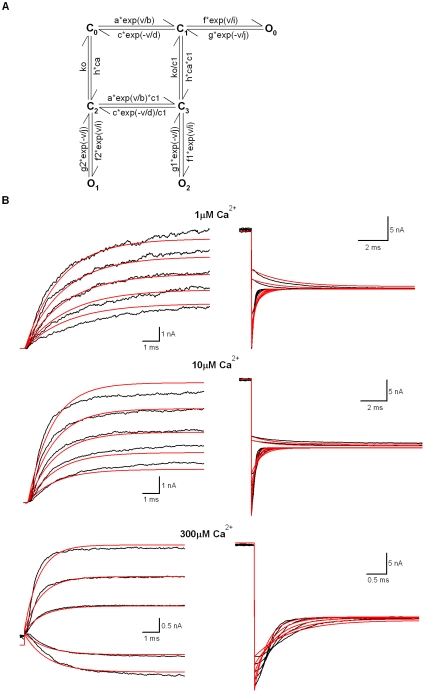
A 7-state BK model used for describing the same currents in

Figure 4

. (A) A 7-state BK model simplified from the 50-state MWC model of BK channels. (B) The parameters of the 7-state model were: a = 342.37 s−1; b = 67.90 mV; c = 56821.90 s−1; d = 168.47 mV; f = 10.21 s−1; i = 232.72 mV; g = 71130.28 s−1; j = 121.54 mV; h = 1330.129 s−1 M−1; c1 = 3.97; kO = 562.23 M; f1 = 105 s−1; g1 = 1323.36 s−1; f2 = 10.02 s−1; g2 = 99575.30 s−1. The score σ2 is 84.99. Compared with the 10-state MWC model, we have .